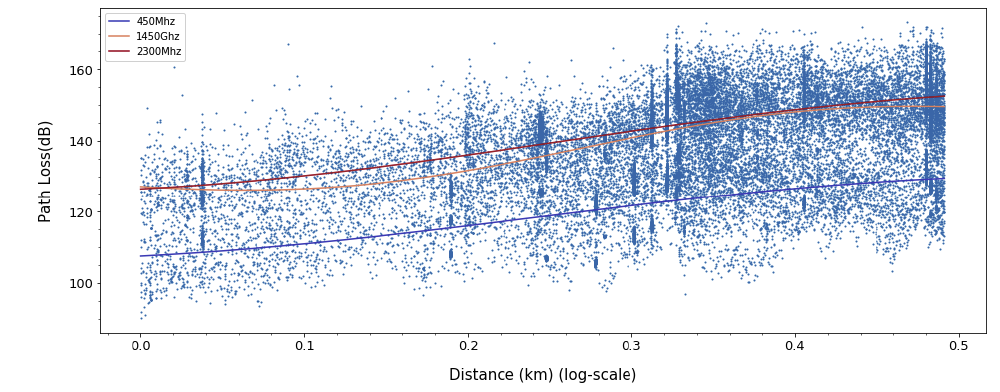
Figure 15. Path loss prediction based on Gaussian process for 450, 1450, and 2300 MHz.